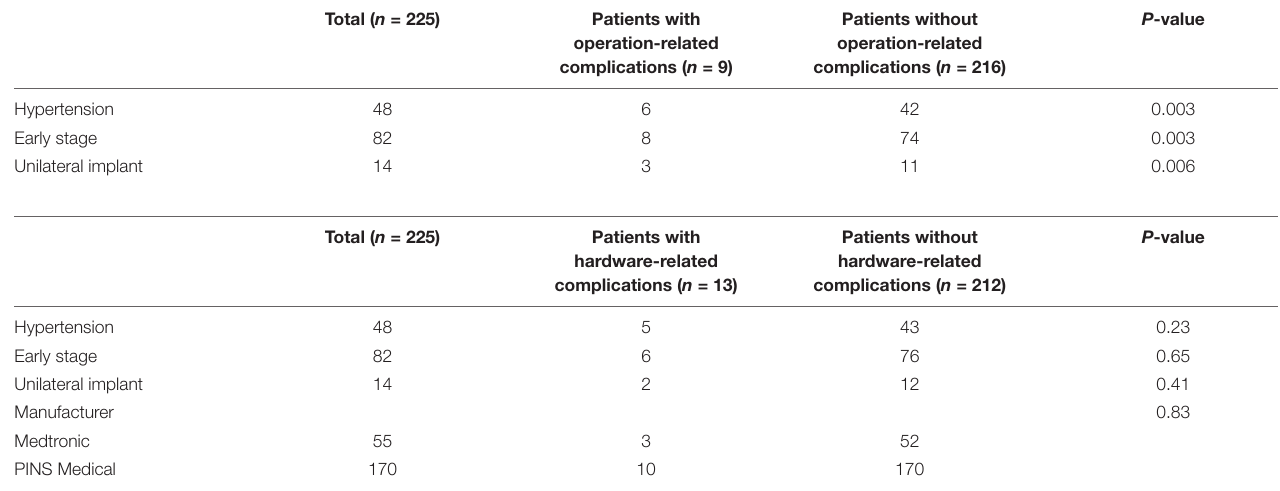
FIGURE 2 | Representative Cases. (A) Cranial CT image of Patient #7 demonstrating the massive intracranial hematoma three days after the surgery, with symptoms of a generalized seizure. (B) Chest X-ray image of Patient #36 showing the fracture of extension wire near the IPG. Enlarged damaged wire in the right upper corner. TABLE 3 | Univariate Analysis of risk factors in complication subcategories with Chi-square Test with Continuity